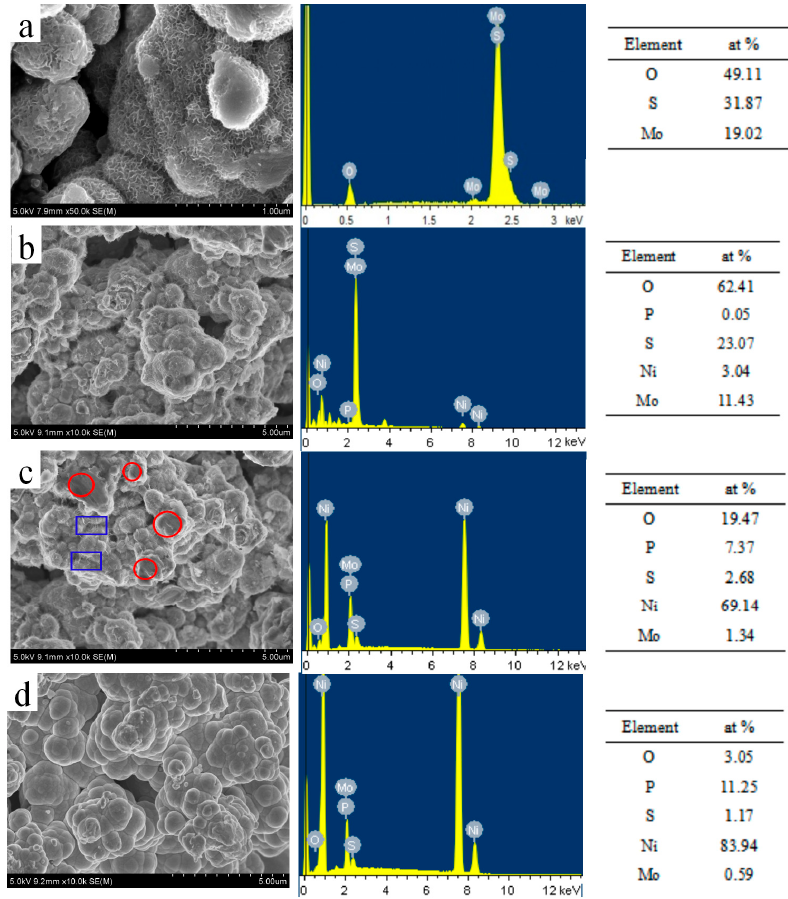
Figure 2. Scanning Electron Microscope (SEM) images and Energy Dispersive Spectrometry